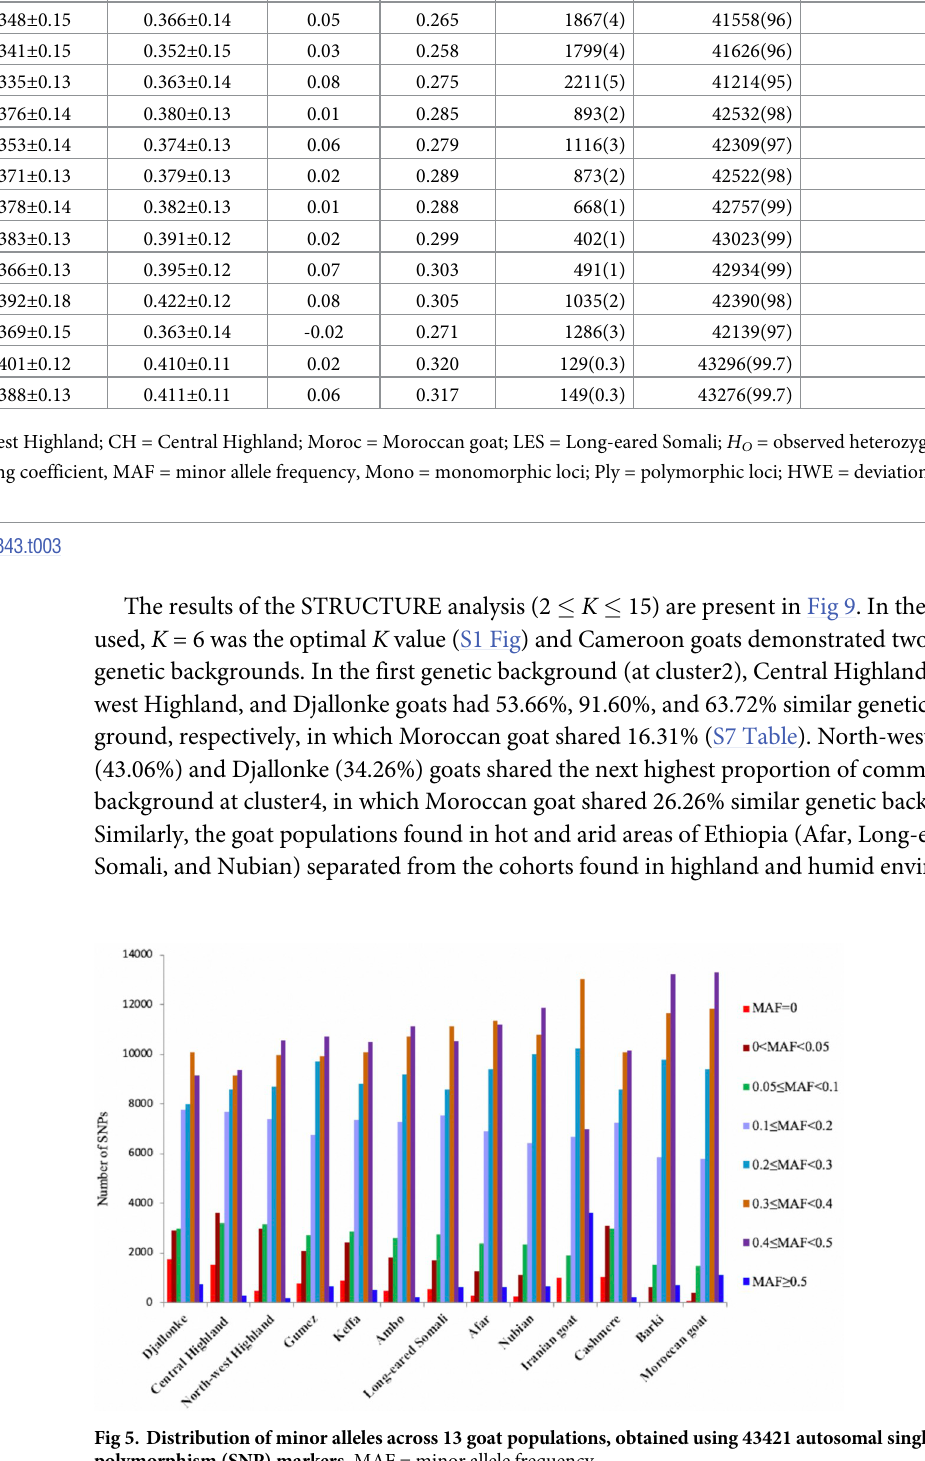
Fig 5. Distribution of minor alleles across 13 goat populations, obtained using 43421 autosomal single nucleotide polymorphism (SNP) markers. MAF = minor allele frequency.